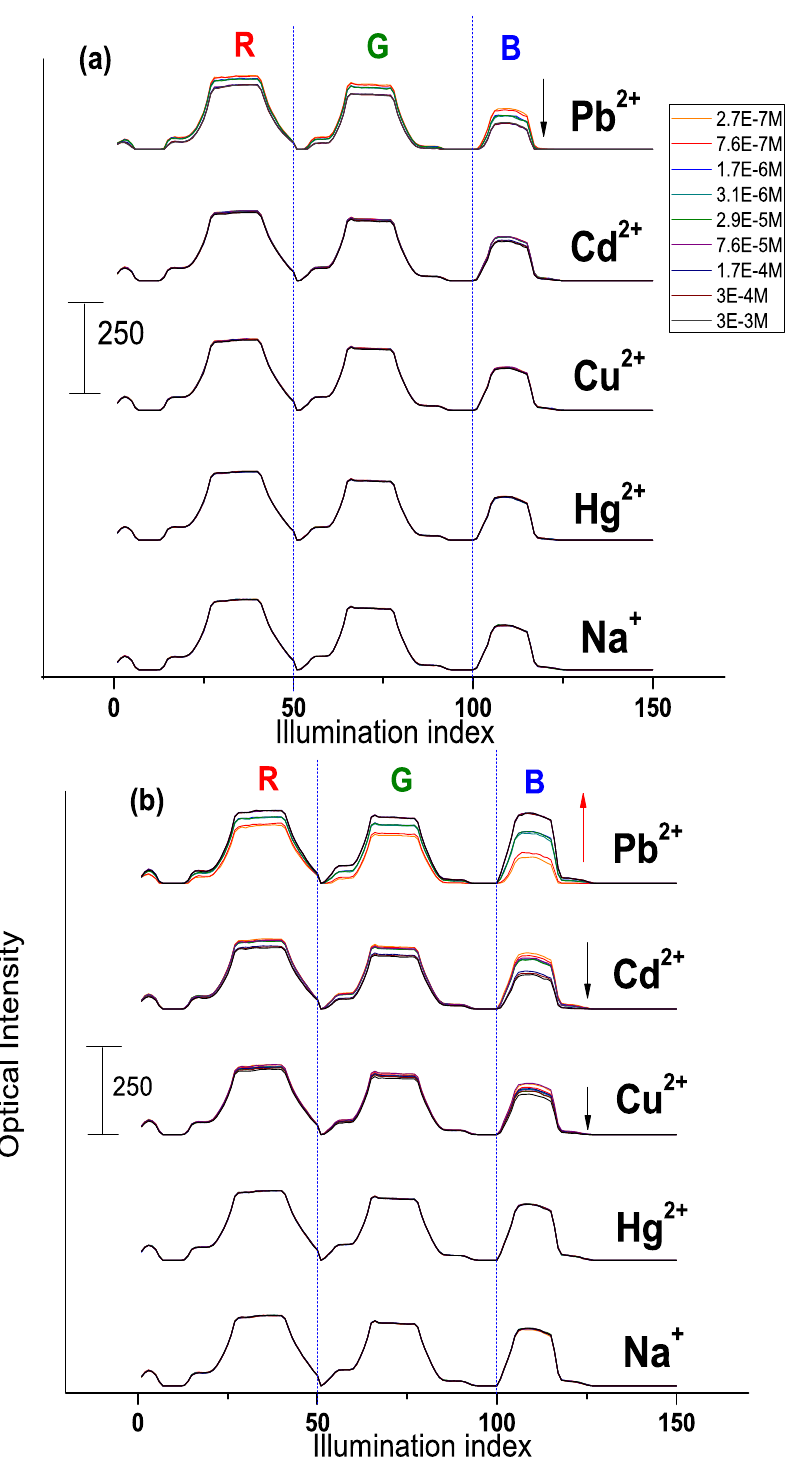
Figure 4. CSPT response of solvent polymeric membranes to several metal ions: ( a ) Mb1 : PVC/DOS/H TFcP 1wt%; ( b ) Mb2 : PVC/DOS/H 2 ( c ) Mb3 : PVC/DOS/H TFcP 1wt%/ TpClPBK 2